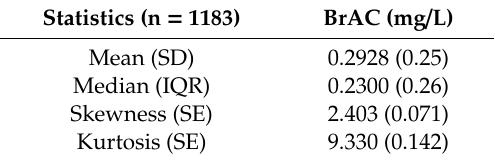
Table 2. Sample demographics and BrAC scores of participants who had a BrAC score higher than 0.